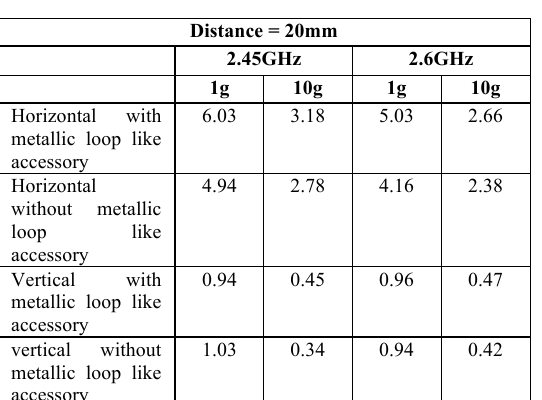
Table 1: The Max SAR value in the presence of metallic loop like accessory at distance 20